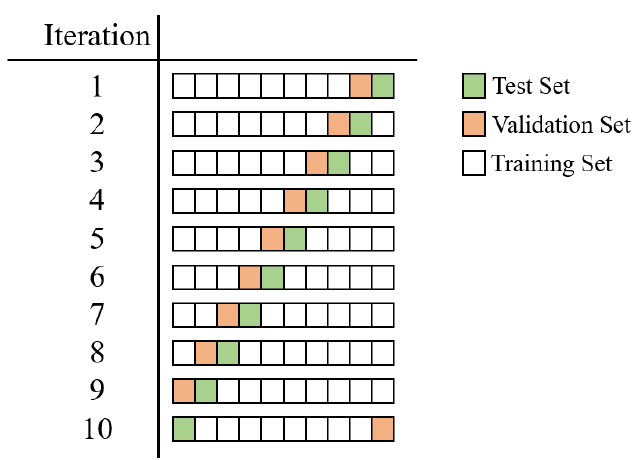
Figure 4. Details about the implemented patient-based 10-fold CV. In the i-th iteration, the i-th fold is selected as the test (green), and the previous one is selected as the validation (orange). The remaining folds are included in the training set.